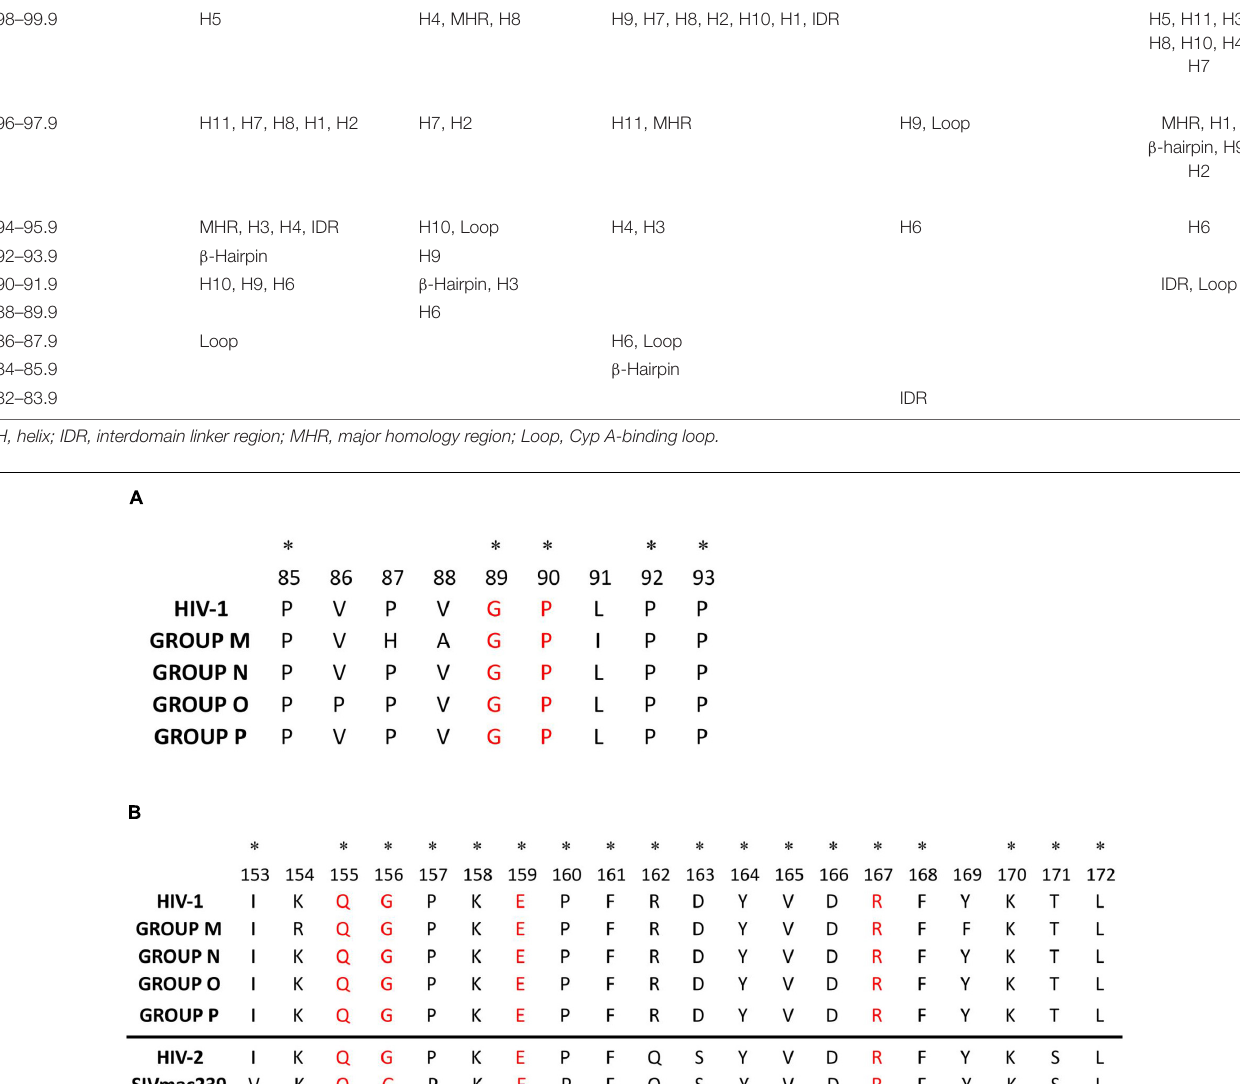
(69.3%), and CRF85_BC was the least conserved CRF (82.2%) ( Figure 4 ). All the other subtypes and CRF showed a p24 conservation above